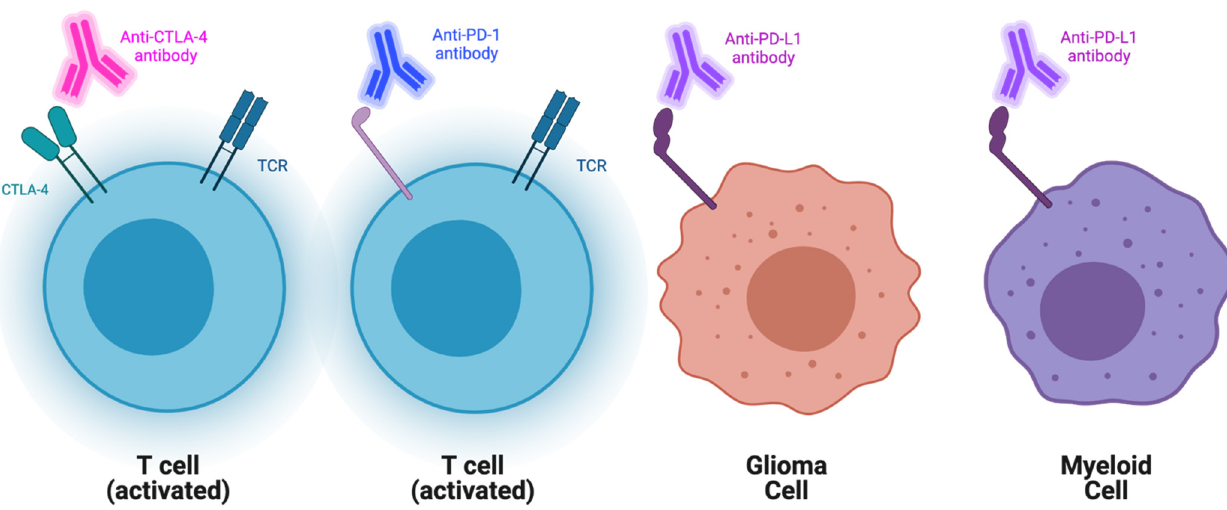
Figure 1. Schematic representation of current checkpoint blockades and their targets. Represented aCTLA-4, PD1, and PDL1 blockades and their main cellular targets.